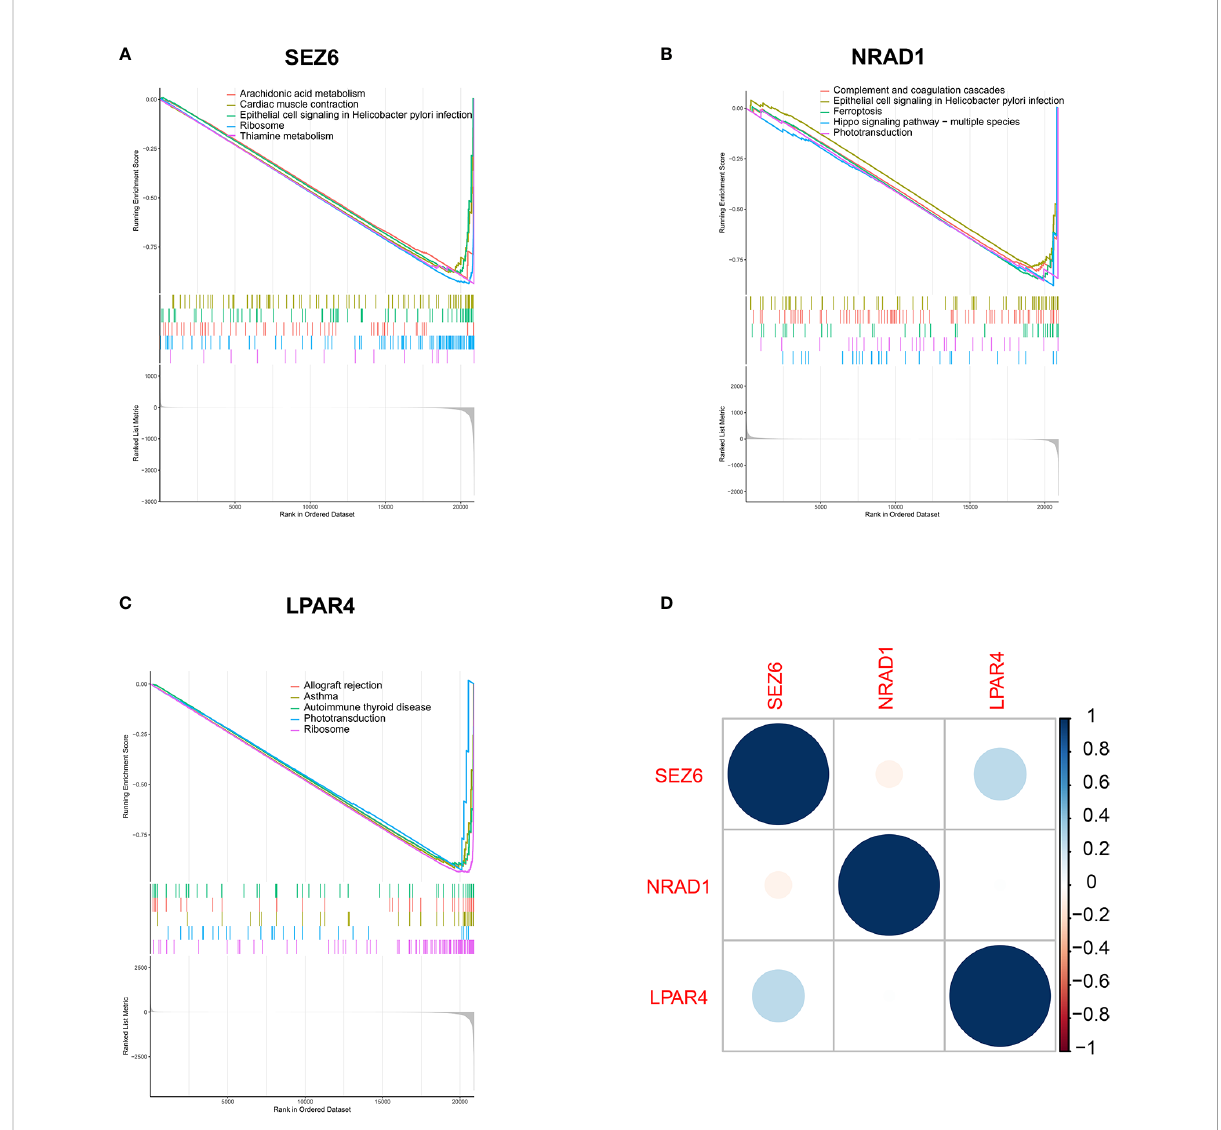
FIGURE 5 Biological pathways analysis in the low-expression group of three feature genes by GSEA analysis. (A – C) Down-regulated gene sets in the low- expression group of SEZ6 (A) , NRAD1 (B) and LPAR4 (C) . (D) Correlation analysis of gene expression of SEZ6 , NRAD1 , and LPAR4 in SLE-APO